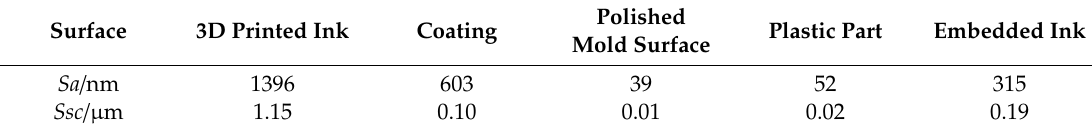
Table 1. Summary table indicating Sa and Ssc parameter results for the analyzed topographies.